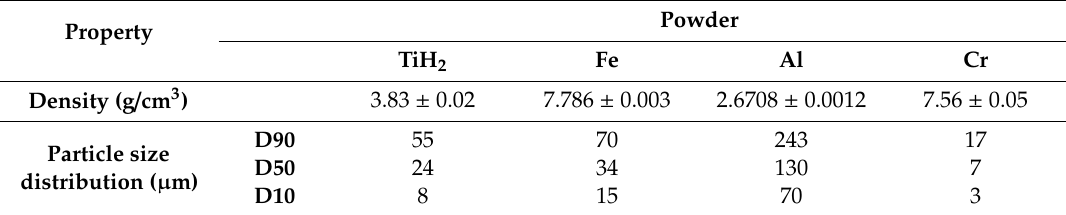
Table 1. Characteristics of the starting